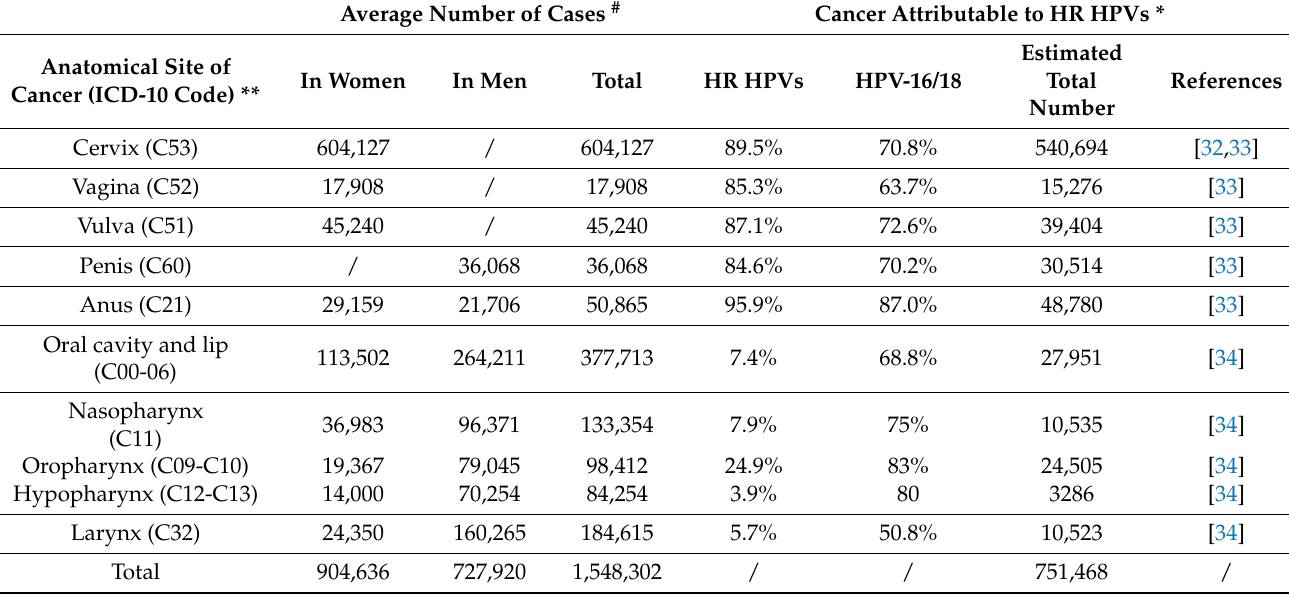
Table 1. Global burden of HPV-associated